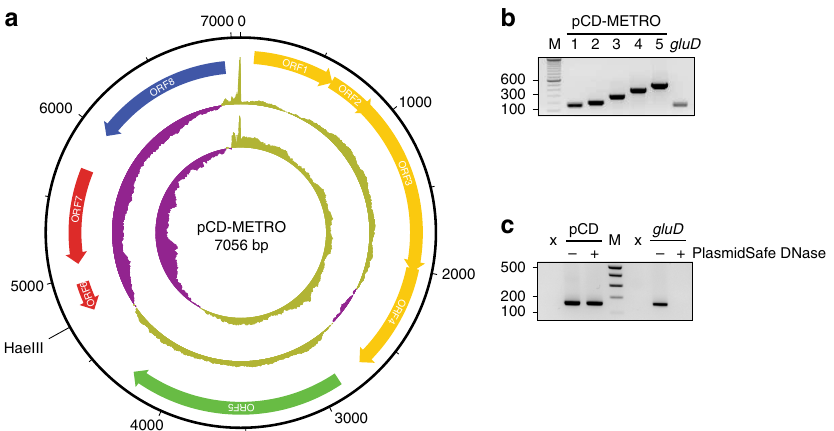
Fig. 2 pCD-METRO is a 7-kb plasmid. a Structure of plasmid pCD-METRO and its ORFs. The two innermost circles represent GC content (outer circle) and GC skew (innermost circle) (both step size 5 nt and window size 500nt;, above average in yellow, below average in purple). The unique Hae III site used to construct pCD-METRO shuttle (see methods) is indicated. b Gene-speci fi c PCR products amplifying regions of ORFs 6 (lane 1 + 2), ORF5 (lane 3), ORF7 (lane 4) and ORF3 (lane 5), and a chromosomal locus ( gluD ) ( c ) The product of plasmid-speci fi c ampli fi cation (targeting ORF6, pCD) or chromosomal- speci fi c ampli fi cation ( gluD ) before and after PlasmidSafe DNase treatment. Source data are provided as a Source Data fi le.